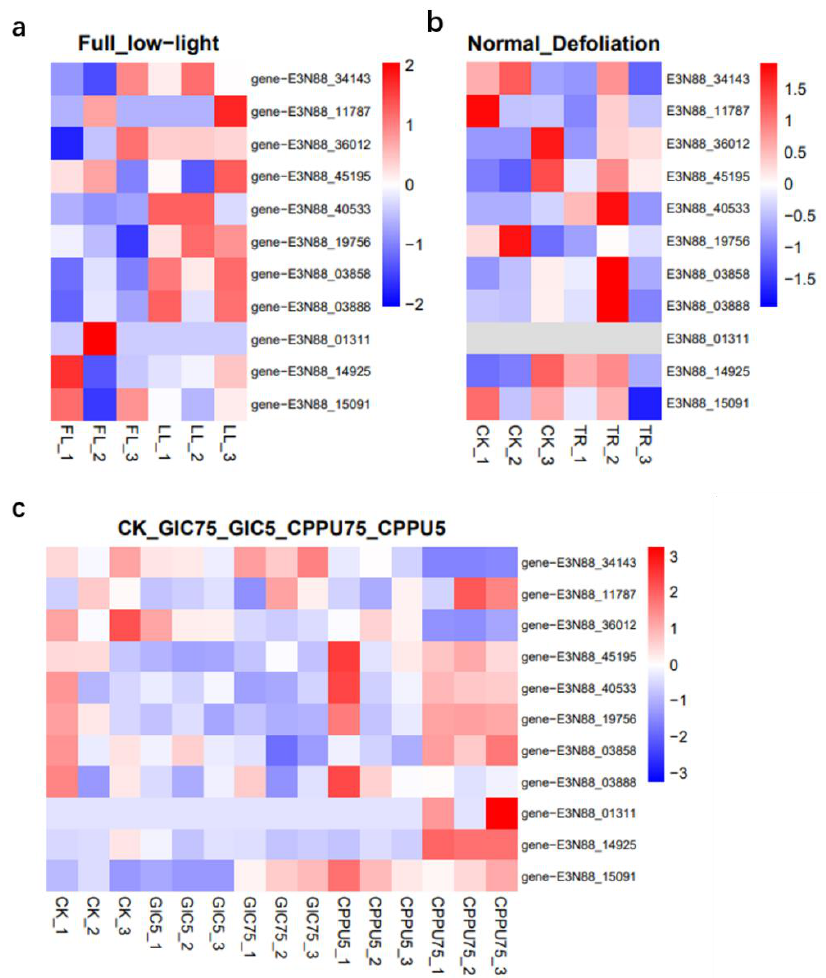
Figure 9. Expression heatmaps of PIN family genes under different treatments. ( a ) The expression of PIN family genes under low-light treatment. (FL = full light (100%), LL = low light (30%)). ( b ) The expression of PIN family genes of M. micrantha in defoliation treatment (CK = undefoliated samples, TR = defoliated samples). ( c ) The expression of PIN family genes of M. micrantha after CPPU or GIC treatments (CK = water application, CPPU5 and CPPU 75 = 5 ppm and 75 ppm of N-(2-Chloro- 4-pyridyl)-N (cid:48) -phenylurea, and GIC5 and GIC75 = 5 ppm and 75 ppm mixture of gibberellic acid, indole-3-acetic acid, and CPPU). The FPKM values were transformed to log2 (value + 1). The color scale is shown at the right, and higher expression levels are shown in